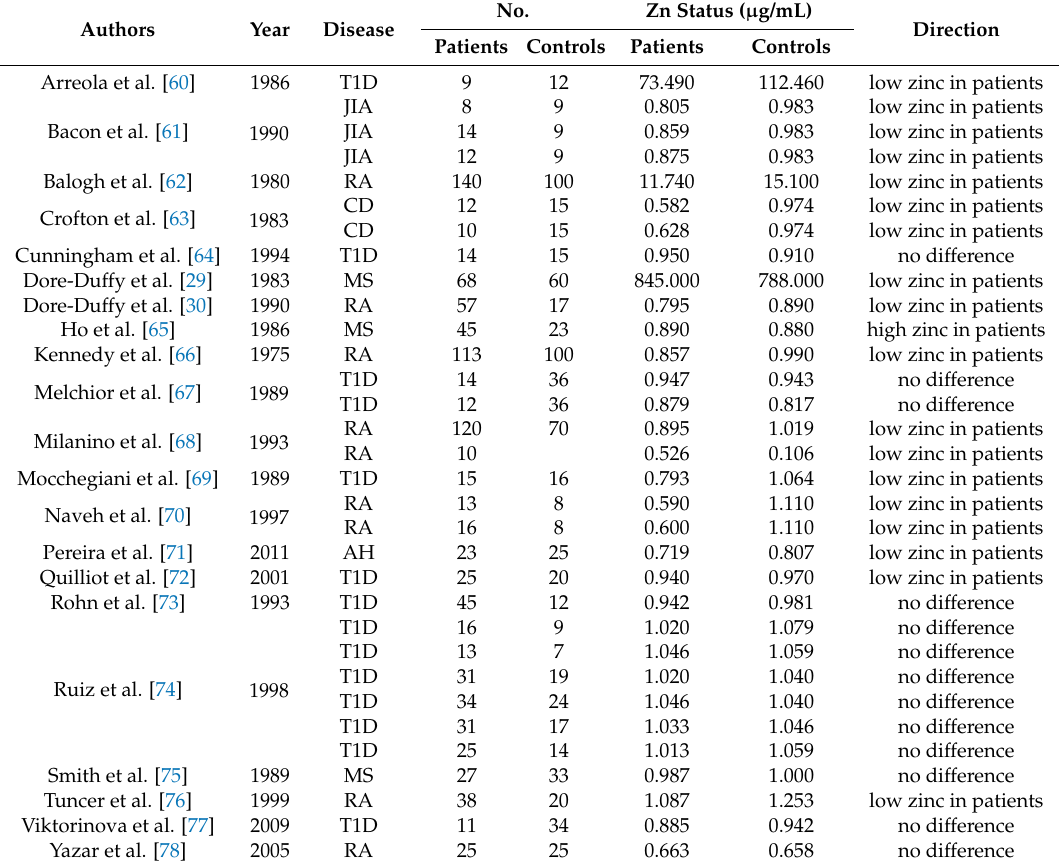
Table 2. Characteristics of selected studies included in meta-analysis in reference to plasma samples.